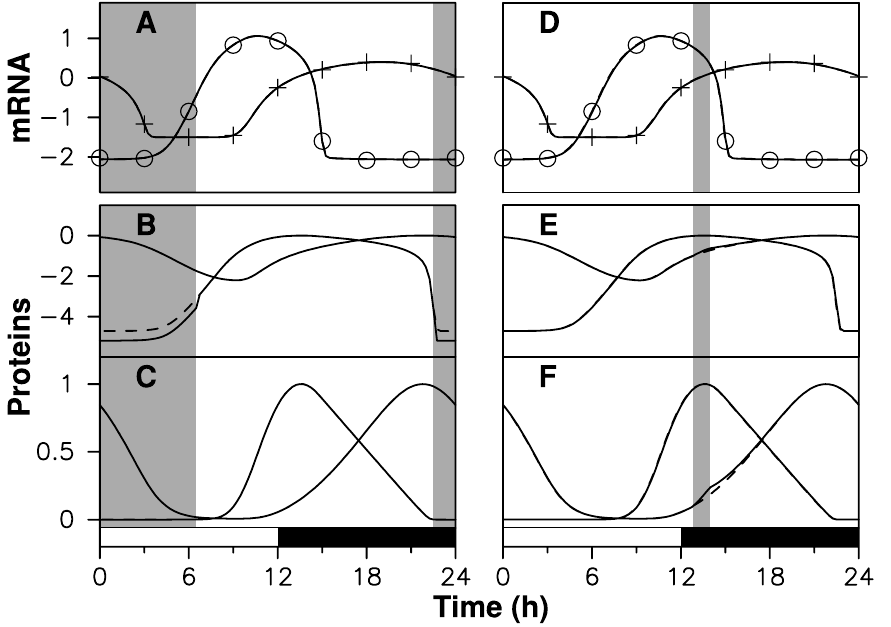
Figure 3. Adjustment by models with gated coupling. Numerical solutions of model (2) without coupling (dashed lines, same parameter values as in Fig 2(B)) and with coupling (solid lines). Gray areas indicate coupling activation. In the left (resp. right) column, TOC1 (resp. CCA1) degradation rate is multiplied by 3 (resp. divided by 2) from ZT22.5 to ZT6.5 (resp. from ZT12.8 to ZT13.95). (A), (D) mRNA time profiles; protein time profiles are shown in (B), (E) logarithmic scale and (C), (F) linear